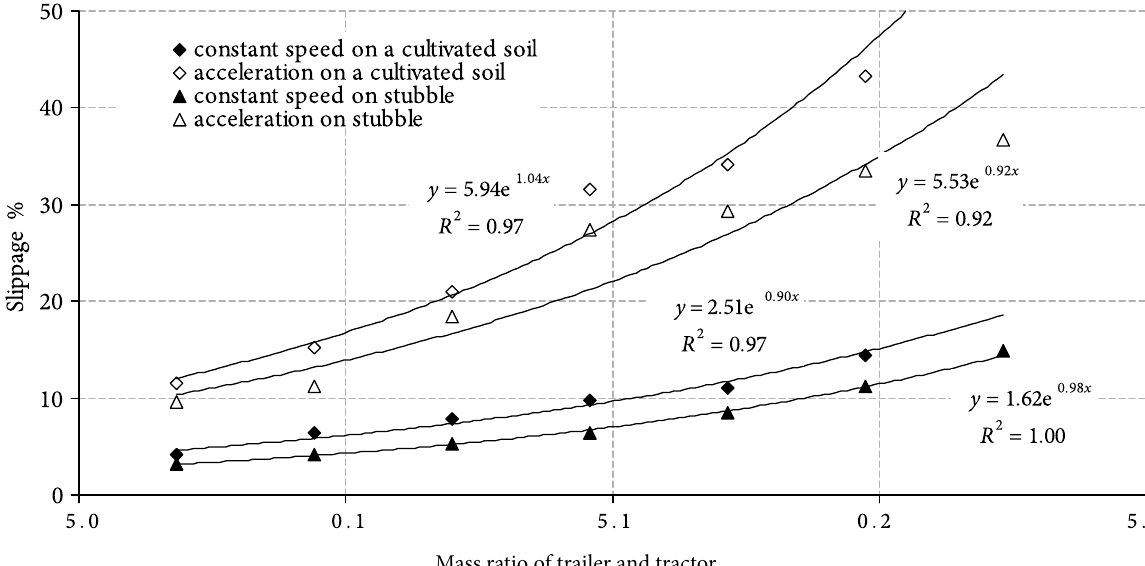
Mass ratio of trailer and tractor Fig. 6. The dependence of wheel slippage on the mass ratio of a trailer and tractor